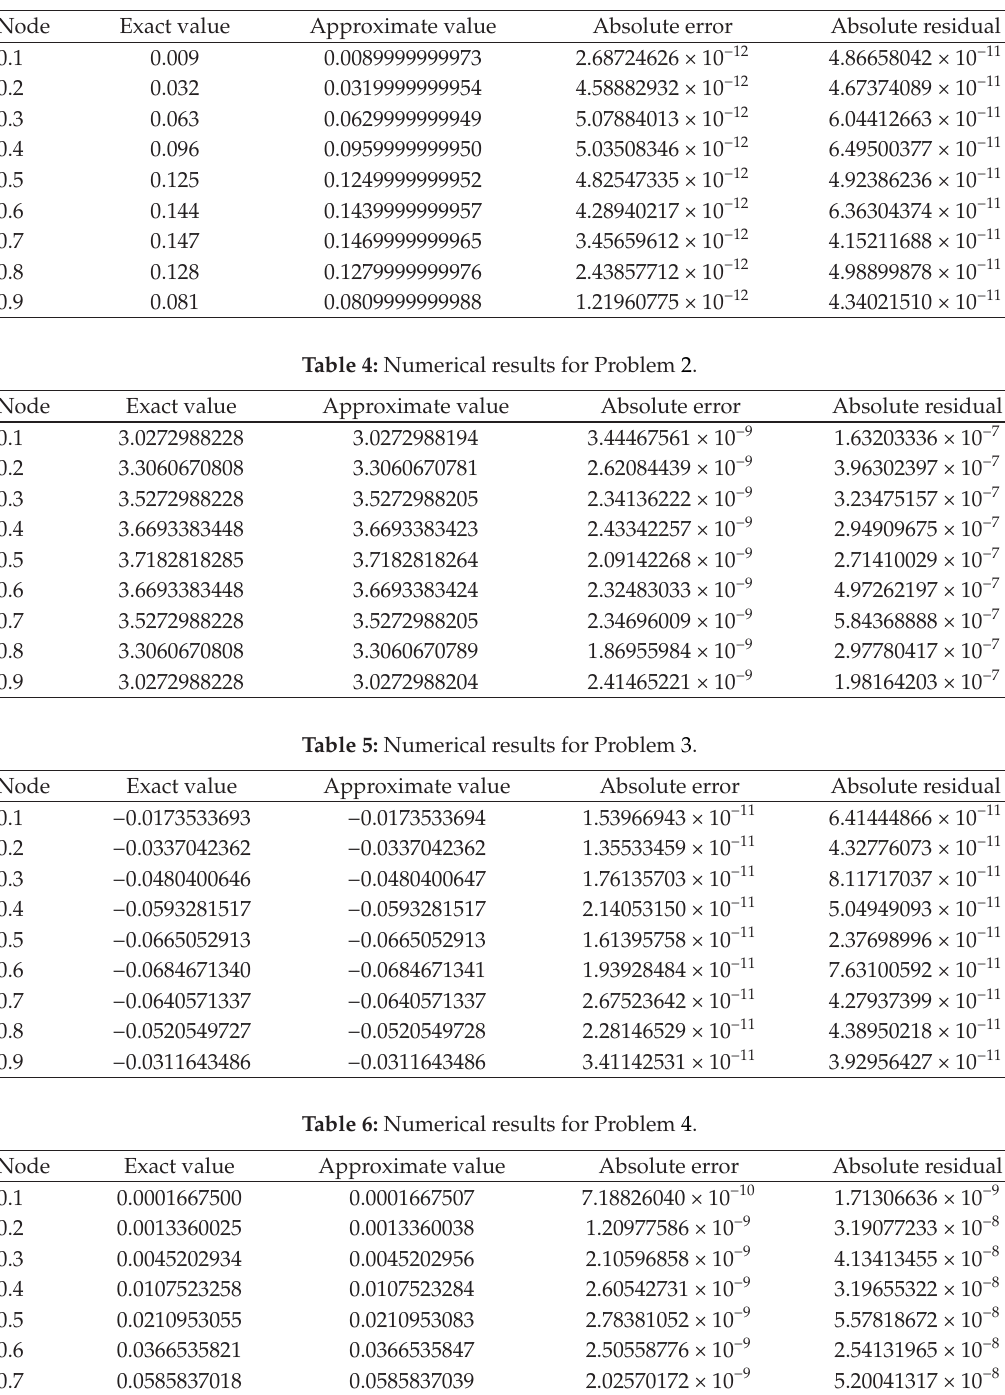
Table 3: Numerical results for Problem 1.